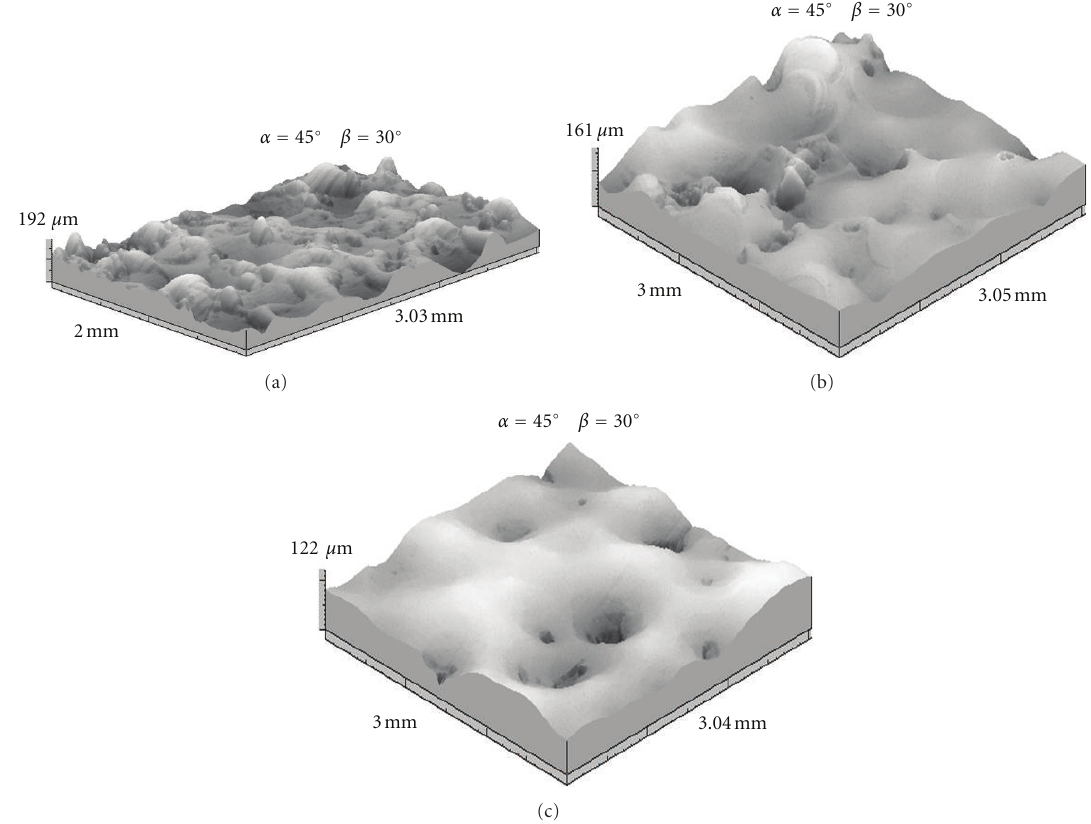
Figure 14: Stereometric image of the surface subjected to the: (a) EDM: cooper electrode, I = 32(A), Ti = 800 ( μ s); (b) EDA: 1H18N9 electrode, I = 32(A), Ti = 3200 ( μ s); (c) EDA + roto peen; n = 4100 (rev/min), t = 75